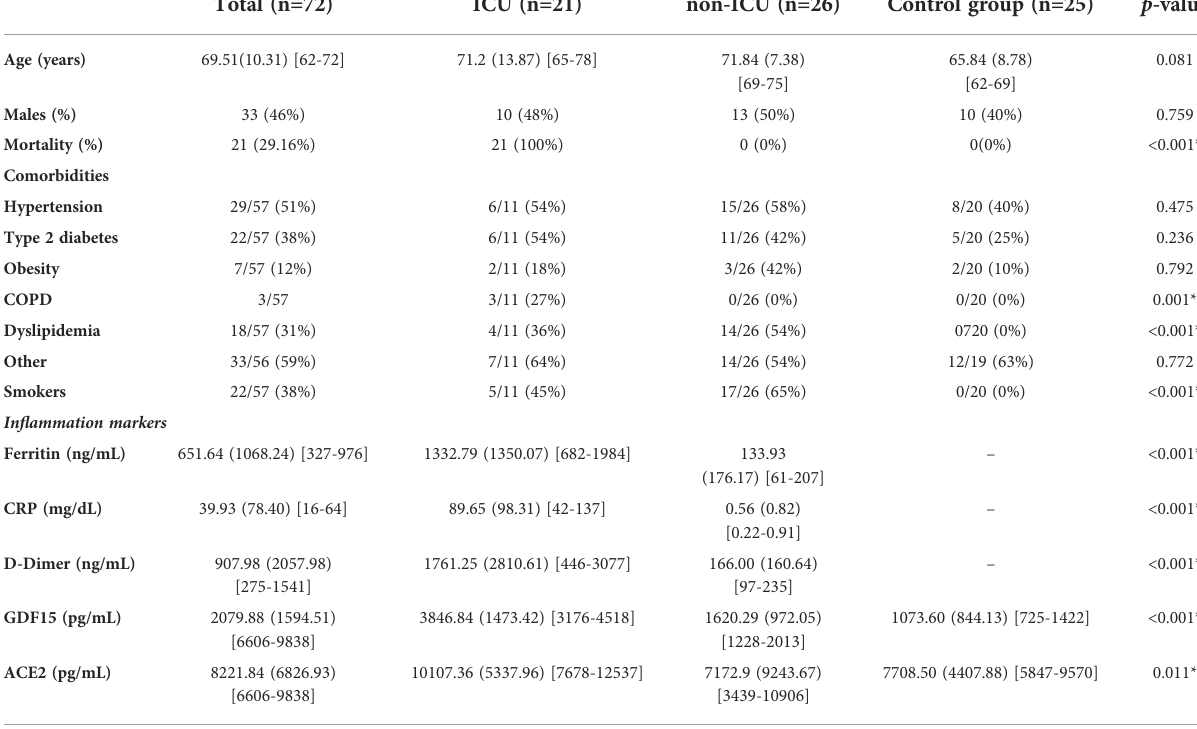
TABLE 1 Baseline characteristics of the sample